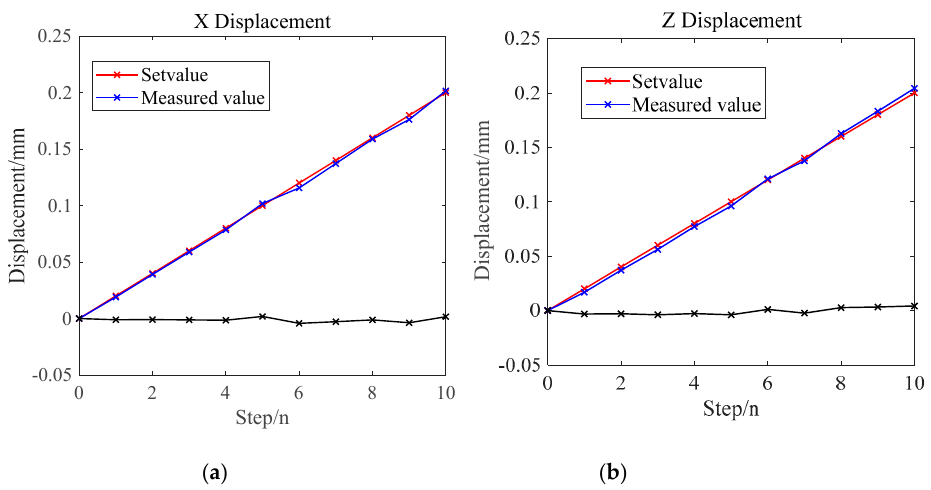
Figure 7. The displacement results: ( a ) X direction and ( b ) Z direction.